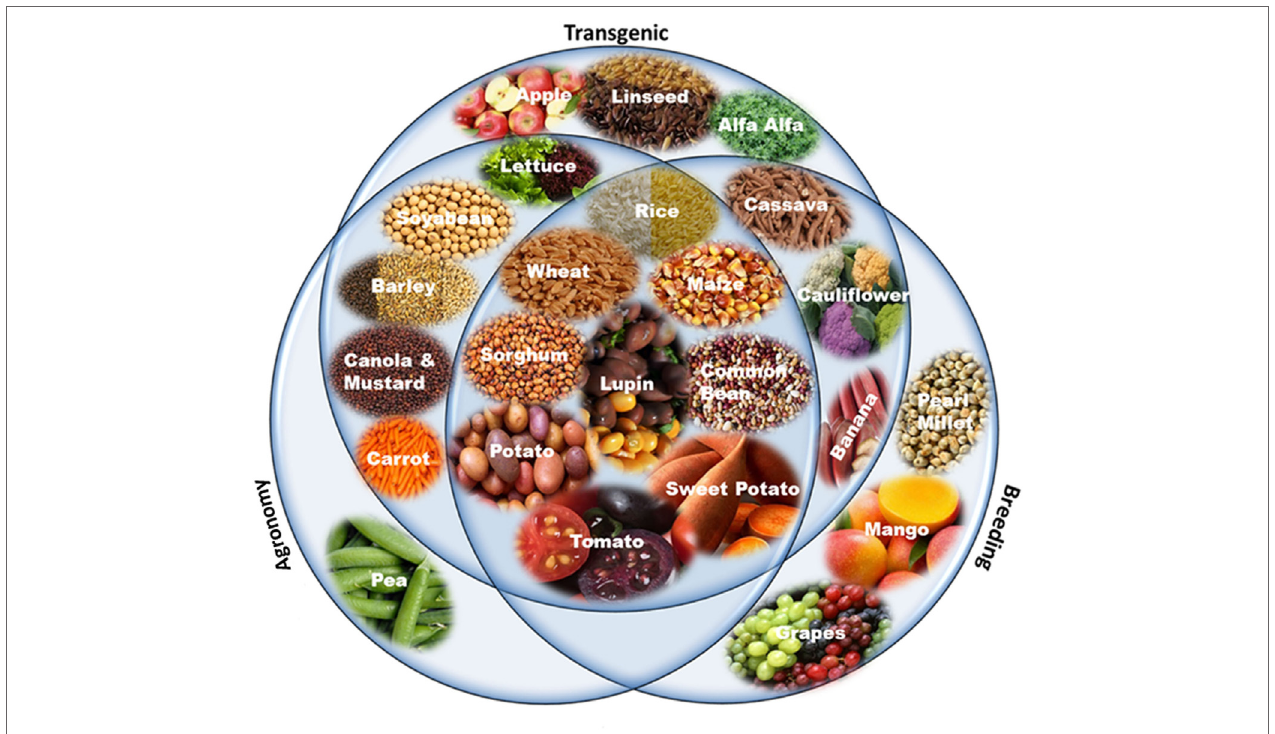
FiGURe 2 | Biofortified crops generated by different approaches: transgenic, agronomic, and breeding. Staple cereals, most common vegetables, beans, and fruits have been targeted by all three approaches. Some crops have been targeted by only one or two approaches depending on its significance and prevalence in the daily human